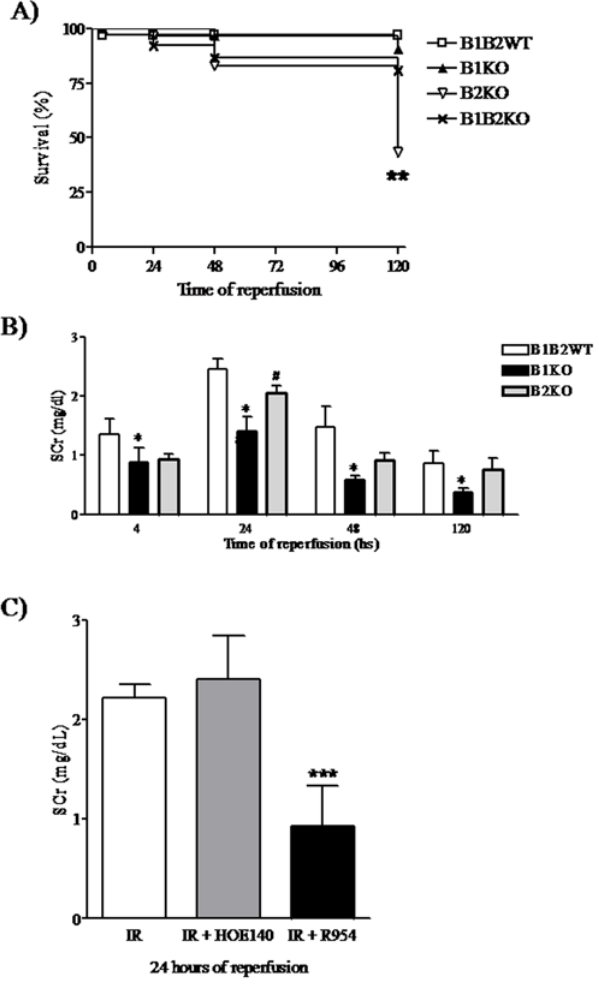
Figure 2. Animal survival and renal function after bradykinin receptor deletion or antagonism. Animal survival was assessed by Kaplan-Meier curve for 5 days after reperfusion. B2KO had the lowest survival at 120 hours of reperfusion (A). Renal function was estimated by serum creatinine levels measured by modified Jaffe´ method. B1KO protection was observed at all times, while B2KO protection was only seen at 4 and 24 hours (B). Thirty minutes prior to the ischemic insult, wild-type animals were treated with B1R or B2R antagonists (R-954 and HOE-140, respectively, both at 200 m g/kg) via i.p and plasmatic creatinine levels were assayed at 24 hours of reperfusion. Only the R- 954 treatment resulted in lower SCr levels (C). Statistical analyses were performed using ANOVA. *B1KO versus B1B2WT, p , 0.05 and # B2KO versus B1B2WT, p , 0.05. ***IR + R-954 versus IR and IR + HOE-140, p , 0.05.